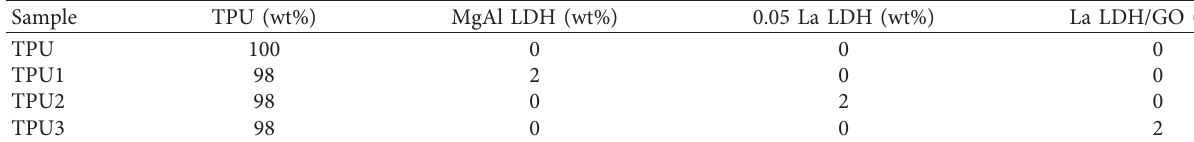
Table 1: Formulas of TPU and TPU composites.